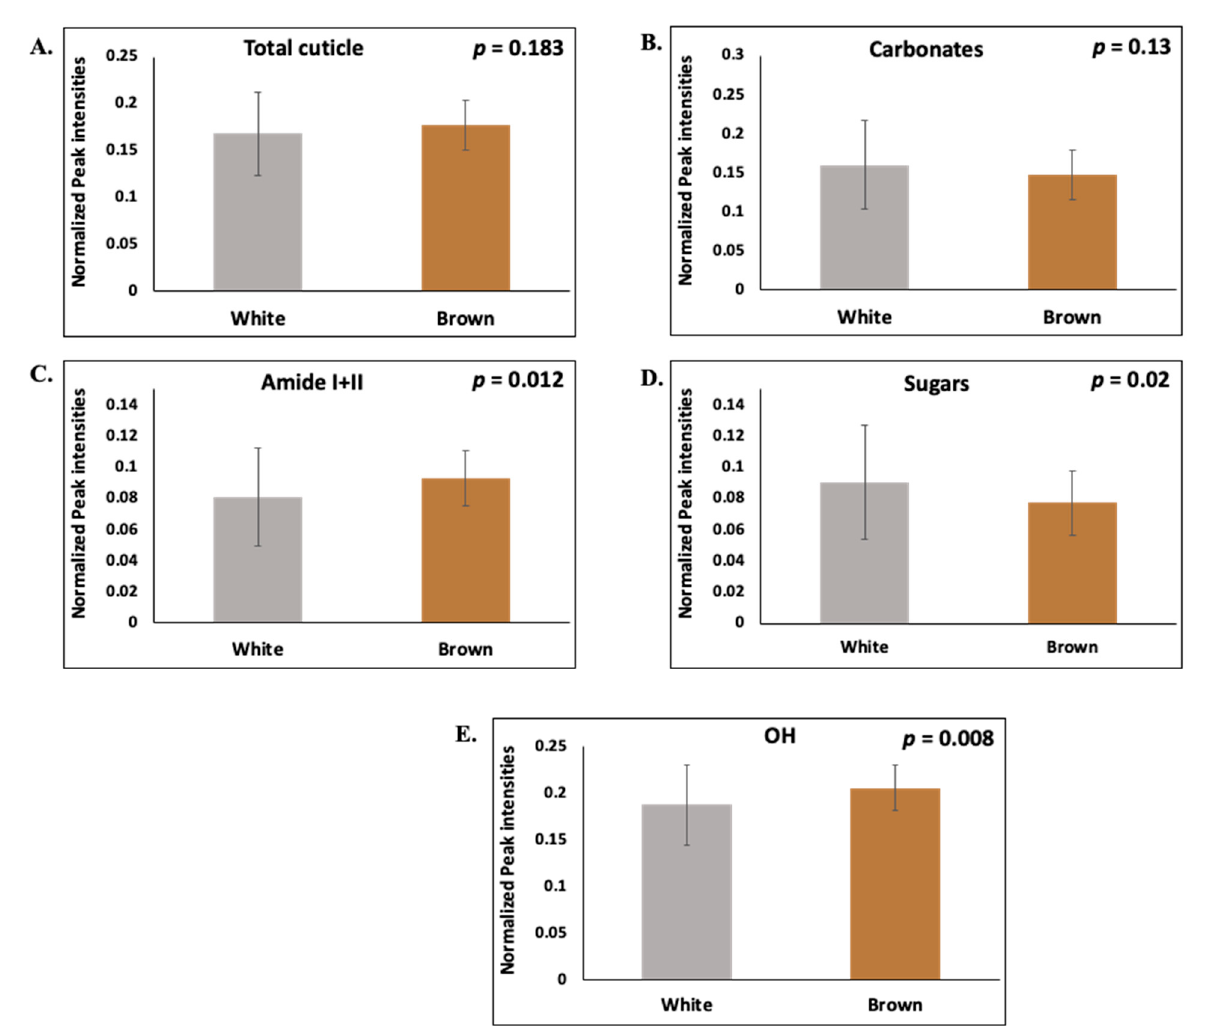
Figure 4. The hen strain dependence of the intensity of ATR-FTIR spectroscopy peaks that were associated with the main chemical components ( A ) Total cuticle, ( B ) Carbonates, ( C ) Amide I + II, ( D ) Sugars/polysaccharides, and ( E ) OH of the eggshell cuticle in white ( n = 90) and brown ( n = 30) eggs. The data shown corresponds to eggs from mid-lay hens. The values represent the mean ± standard deviation (Student’s t -test; p < 0.05).